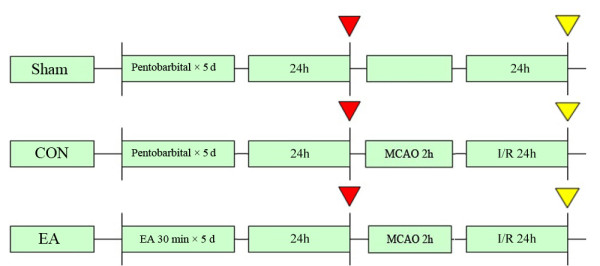
Experimental protocol diagram 1. Eighteen male SD rats were randomly divided into 3 groups(n = 6 each): Sham, CON, EA group. At 24 h after the last EA pretreatment (red arrow), the rats (n = 3) from 3 groups were killed for real-time RT-PCR analysis for Notch1, Notch4, Jag1 and Hes1 genes. At 24 h after reperfusion (yellow arrow), the rats (n = 3) from 3 groups were killed for double immunofluorescent staining to show the NICD immunoreactivity.